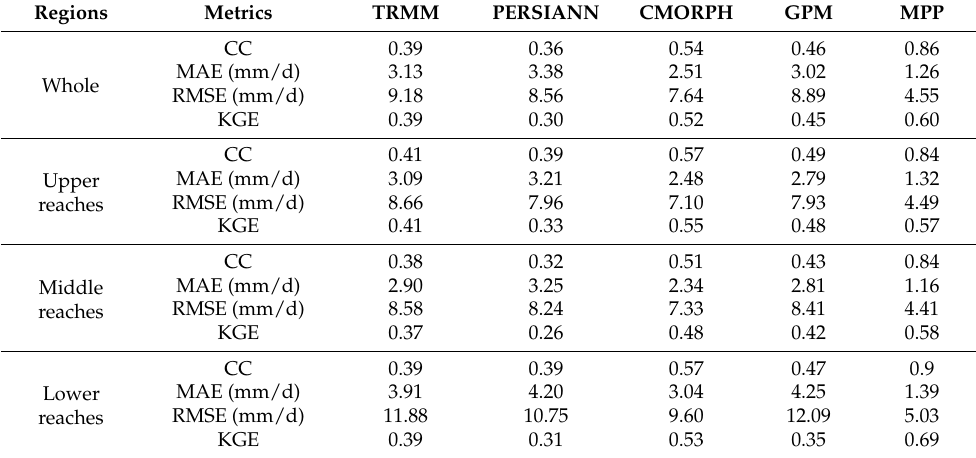
Table 5. CC, MAE, RMSE, and KGE of the final MPP and the original four SPPs with reference to gauge observations across the whole, upper, middle, and lower reaches of the Hanjiang River during